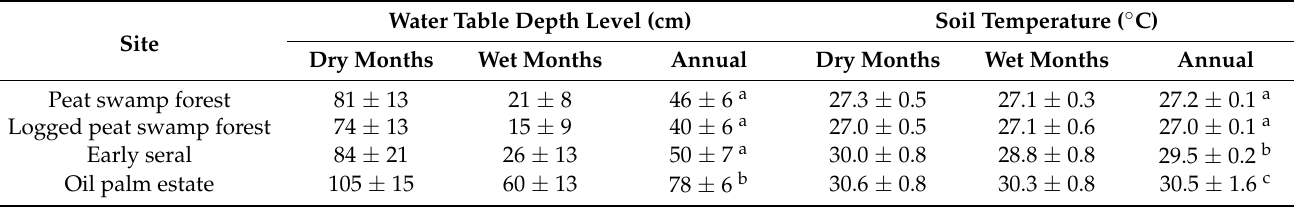
Table 5. Water table depth and soil temperature (means ± SE) of intact peat forest (PSF), logged peat forest (LPSF), early seral (ES), and oil palm (OP) during wet and dry months and annually. Superscripted letters denote a significant difference ( p < 0.05) when testing between land cover types. Water Table Depth Level (cm) Soil Temperature ( ◦ C) Site Dry Months Wet Months Annual Dry Months Wet Months